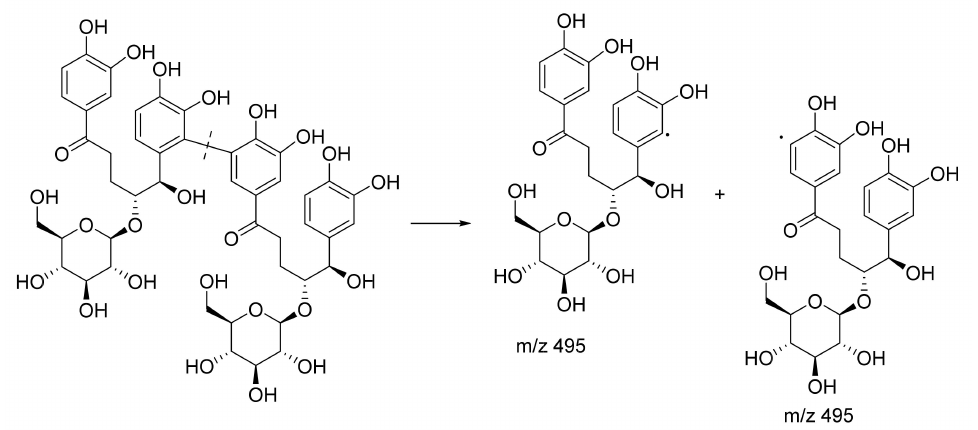
Figure 7. Proposed fragmentation pathway for the dimer of